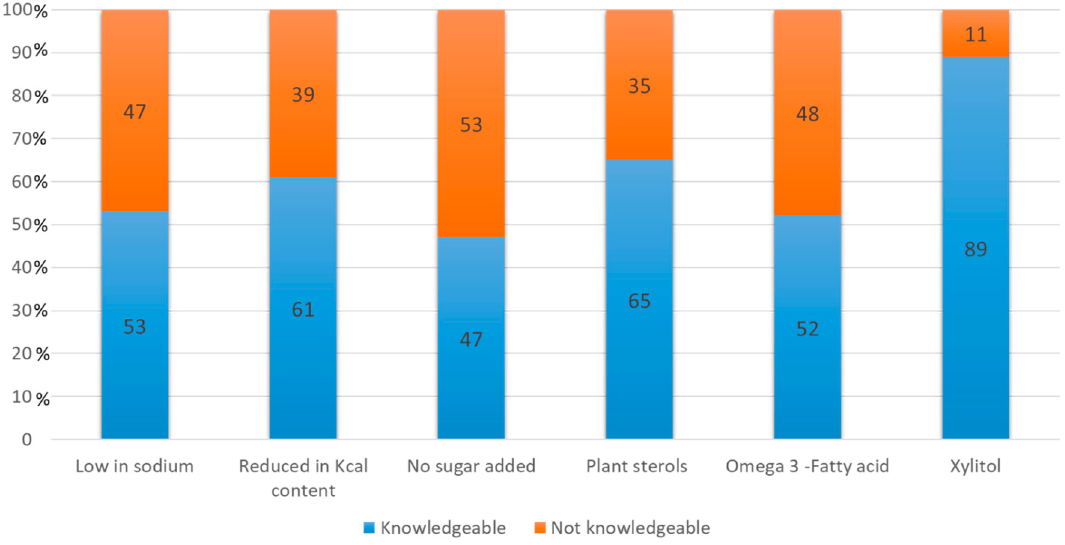
Figure 1. Share of interviewees who knew the actual meaning of the selected NHCs.